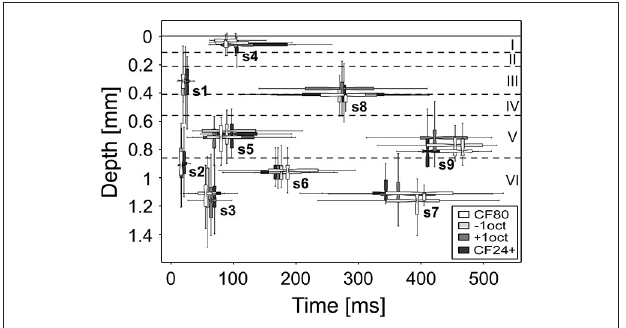
FIGURE 8 | Onset latency and depth of stimulus-specific sinks. The range of the onset depth is displayed at the median of the respective onset latency. The sinks remain relatively constant regarding the layer and time at which the neuronal activity is evoked. Boxplot whiskers represent data range, outer edge of box represents second and fourth quartiles of data, and midline represents median of